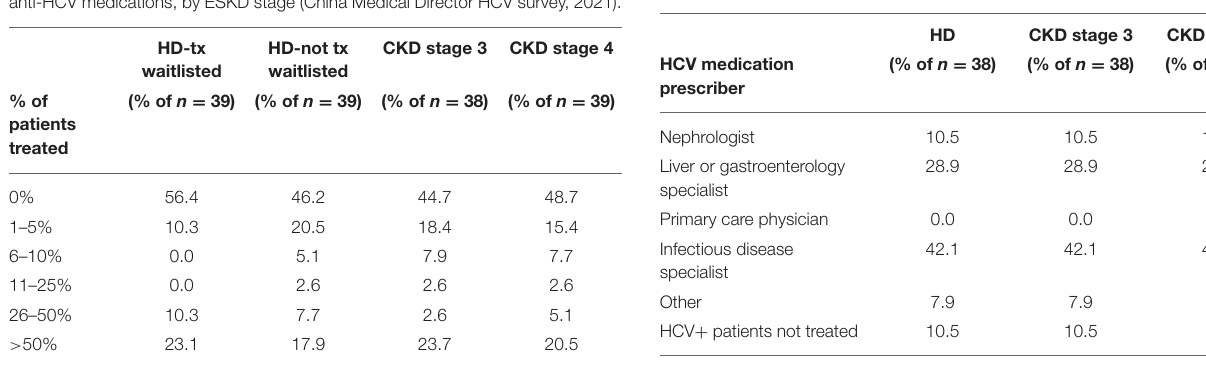
TABLE 10A | Physician type who usually prescribed antiviral medications to treat HCV + patients, by ESKD stage (China Medical Director HCV survey, 2021).